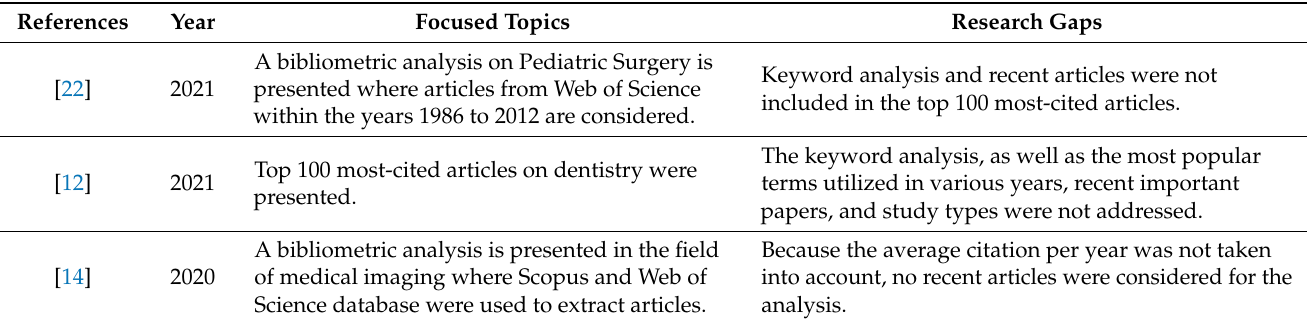
Table 1. Summarized analytical evaluation of review